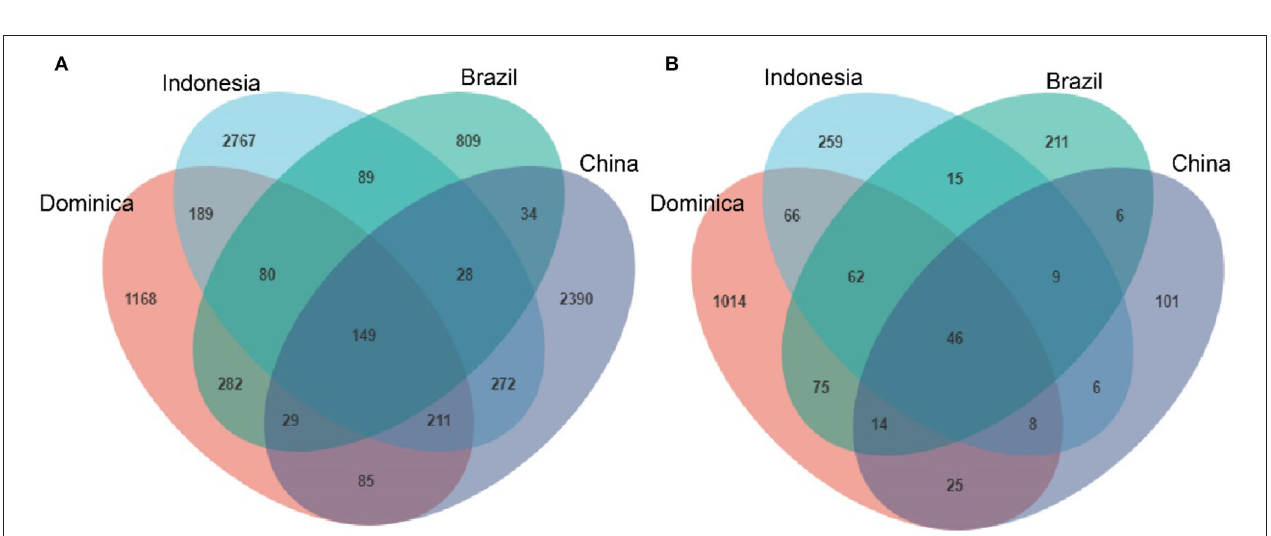
FIGURE 3 | Numbers of unique and shared bacterial (A) and fungal (B) microbiota in cigar tobacco from different regions.